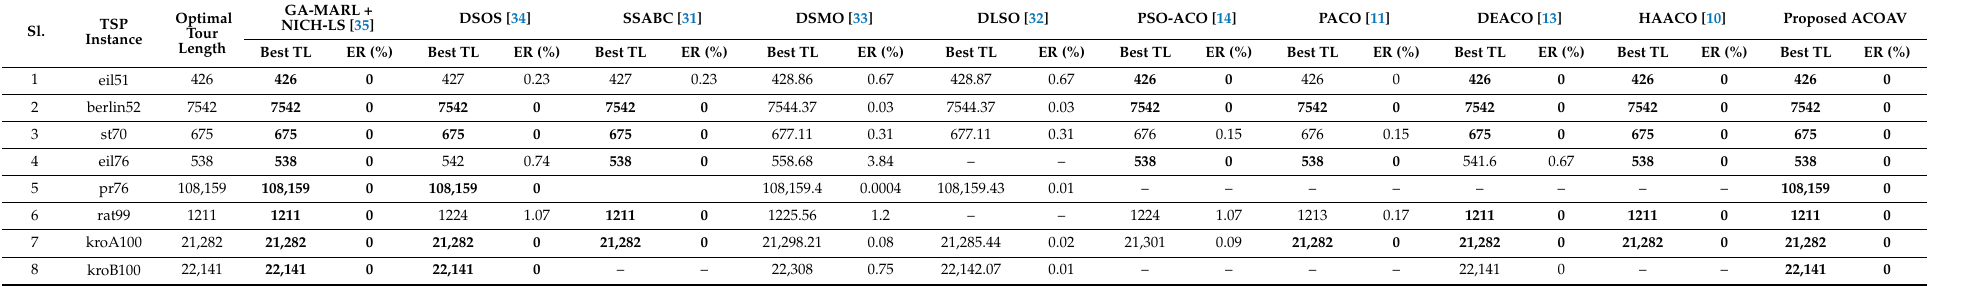
Table 2. Best Tour Length (TL) and Error Rate (ER) Comparison of ACOAV with Existing State-of-the-Art Bio-inspired Methods.